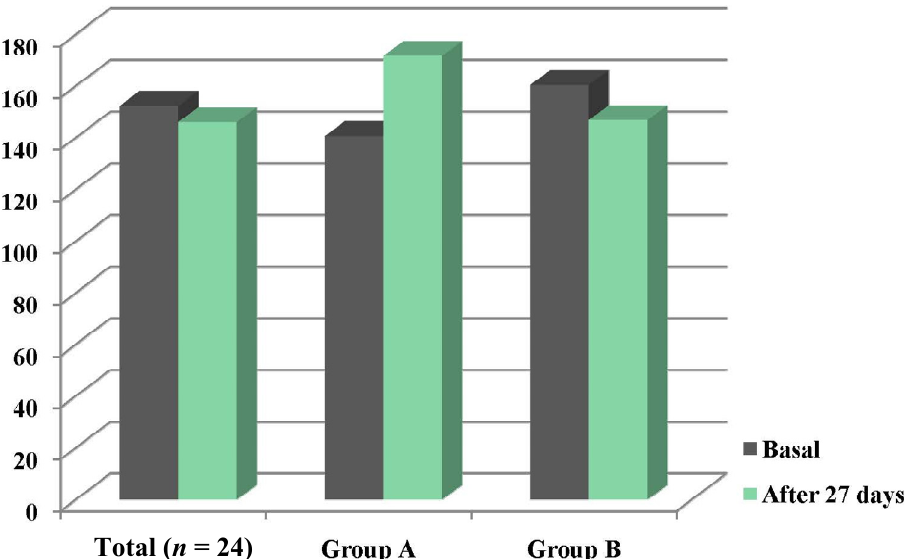
Figure 1. Plasma zinc levels of the total sample, group A and group B at basal condition